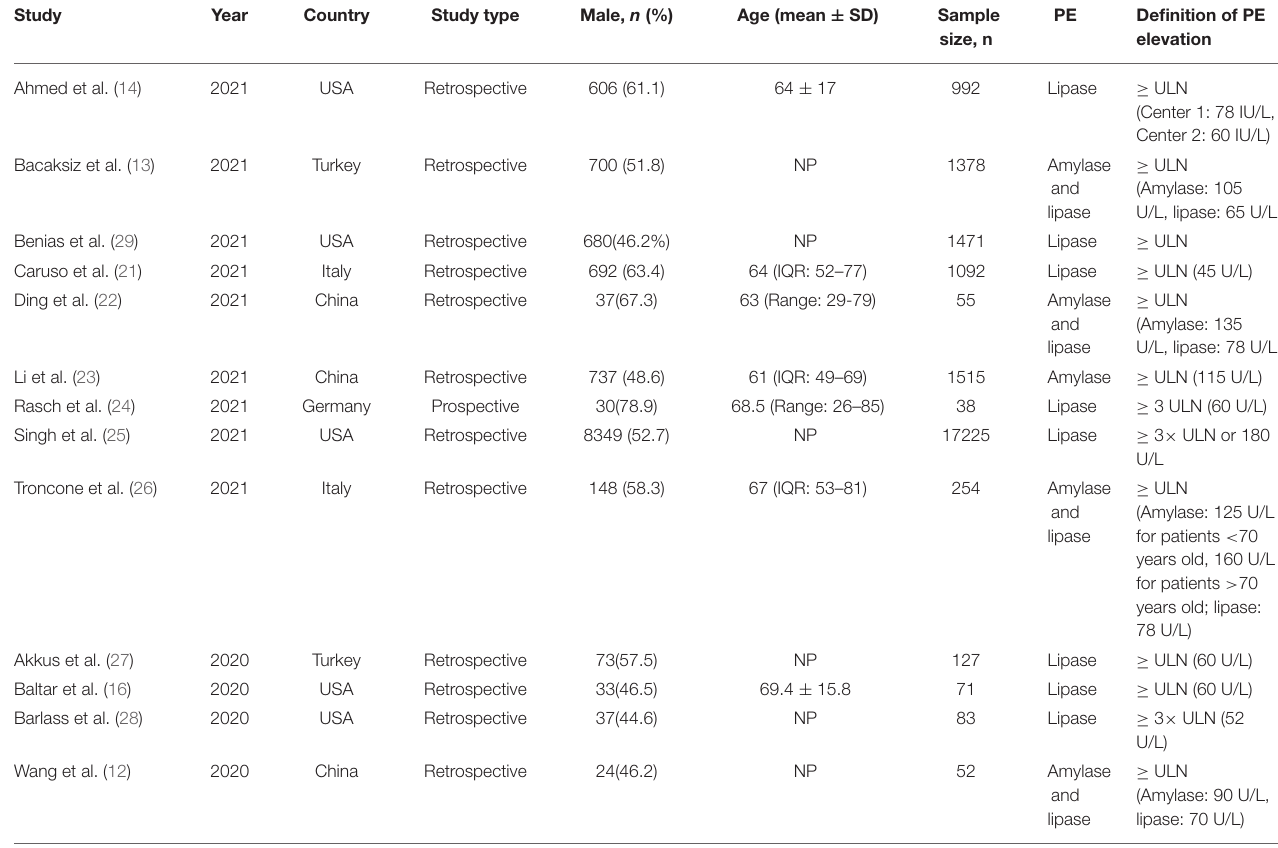
TABLE 1 | Characteristic of studies reporting pancreatic enzymes elevation in COVID-19 patients.